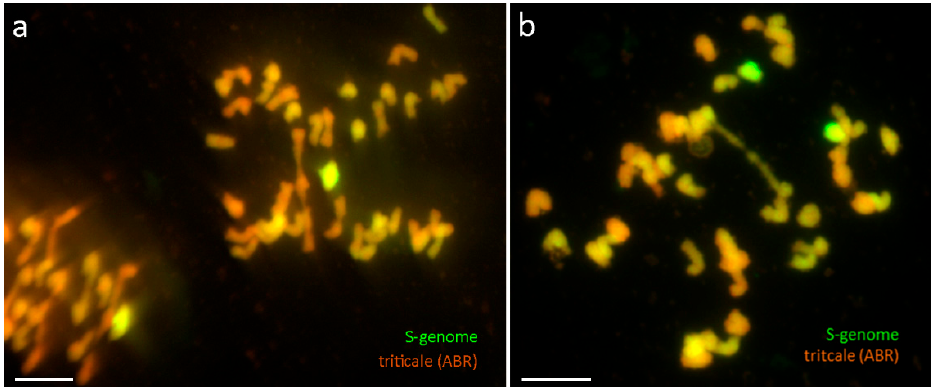
Figure 4. ( a ) Chromosome segregation of 2S k (green, Atto-488) at anaphase I of triticale line 40 + M2RS + M2RL + M2S k . ( b ) Centric misdivision of chromosome 2S k (green, Atto-488) at anaphase I of triticale line 40 + M2RS + M2RL + M2S k . Scale bar, 10 µ m.